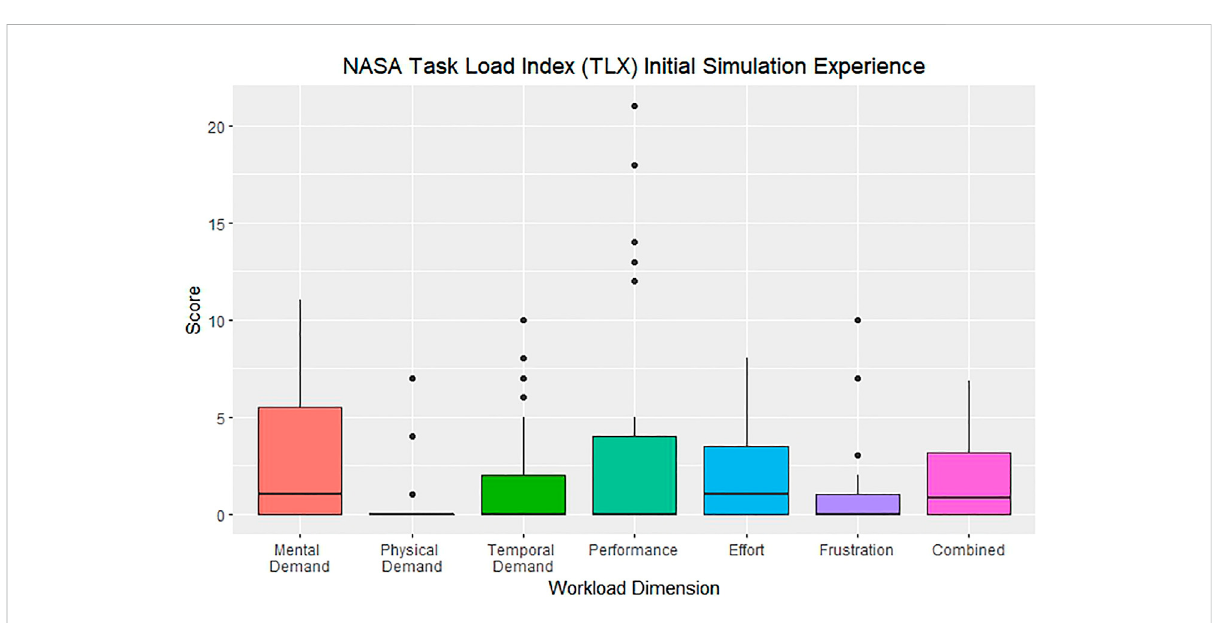
FIGURE 3 NASA Task Load Index results for the familiarization